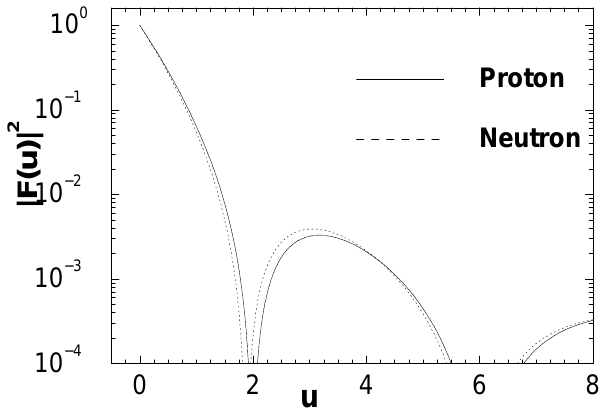
Figure 10. Squared proton and neutron form factors for 40 Ar for the ground state.